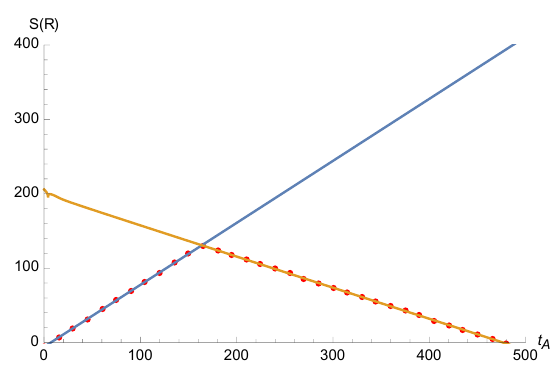
Figure 6 . The fine-grained entropy S ( R ) in the non-equilibrium state in the full reduction. The solid blue line corresponds to the entropy evaluated on the trivial island (3.17) and the decreasing orange line to the entropy evaluated on the non-trivial island (3.20). The fine-grained entropy is given by the minimum of both contributions indicated by the red dotted line. To produce the figure we took ‘ = 1 , Φ s = 50 , Φ 0 = 100 , c = 10 , ˆ r/‘ = 10 3 .